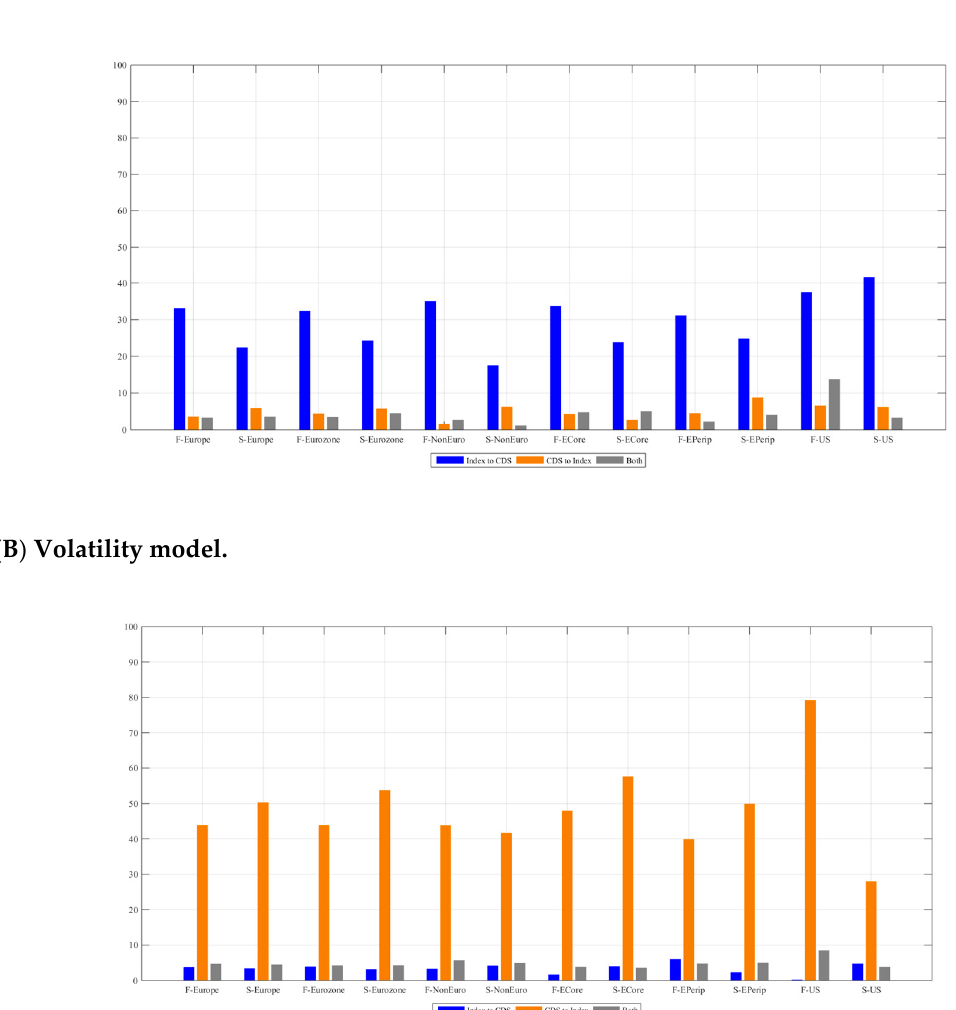
Figure 8. This figure shows the comparative Granger causality test results between financial (F) and sovereign (S) lead–lag relationships between stock returns and CDS returns ( Panel ( A )) and stock conditional volatility returns and the CDS returns ( Panel ( B )) for the full sample period (6 January 2004–12 April 2016) for European countries, distinguishing between Eurozone and non-Eurozone (NonEuro) and, within the Eurozone, between Euro-core (ECore) and Euro-peripheral (EPerip) and the US. For each zone, we present the number of times (in percentage) that the null hypothesis of Granger causality is rejected. Blue, orange and grey bars show if the stock market returns Granger-cause CDS returns, vice versa or both.